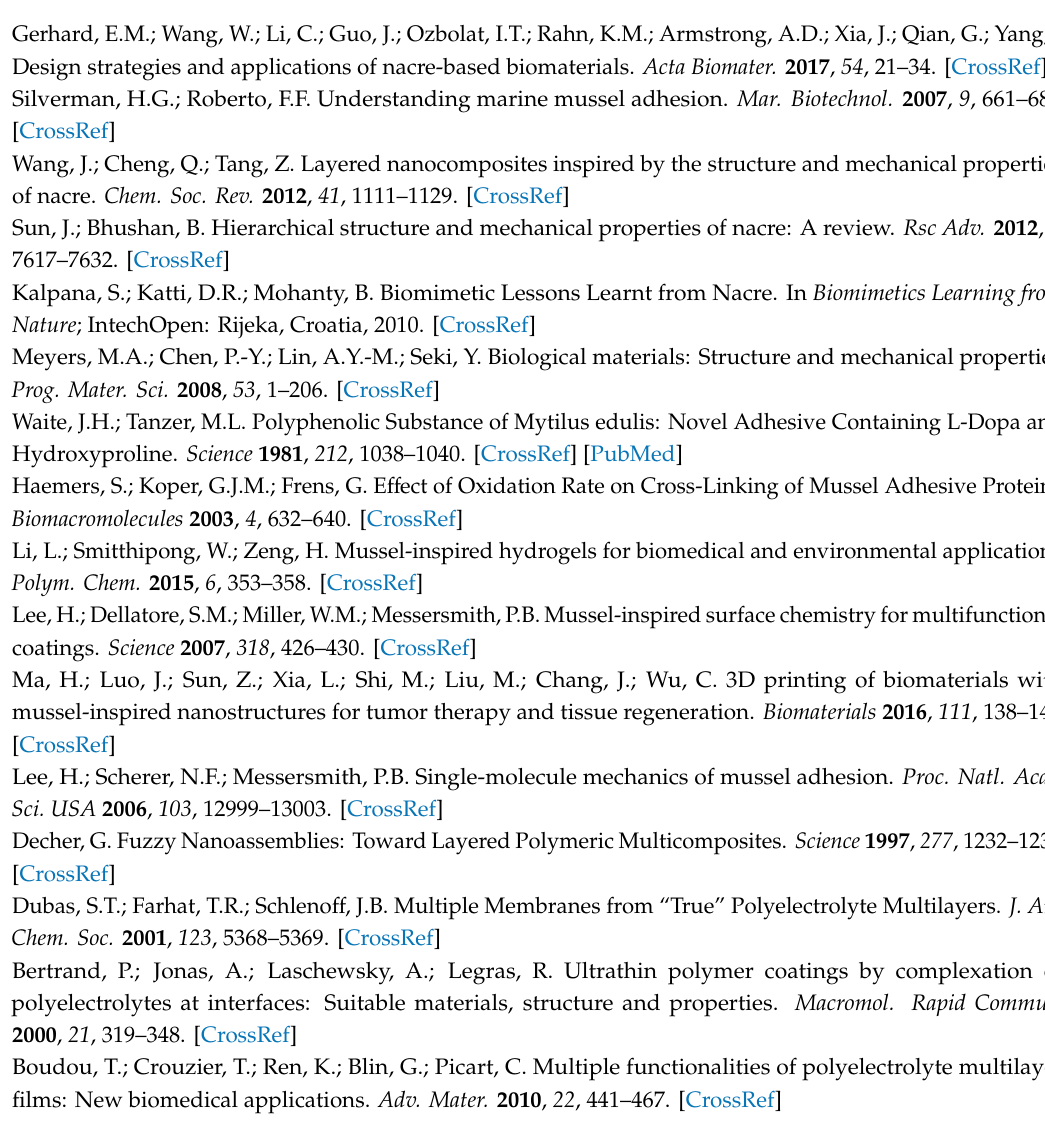
Figure A10. Shear viscosity measurements plotted against the concentrations of CHI, CHIcat, HA, and HAcat.